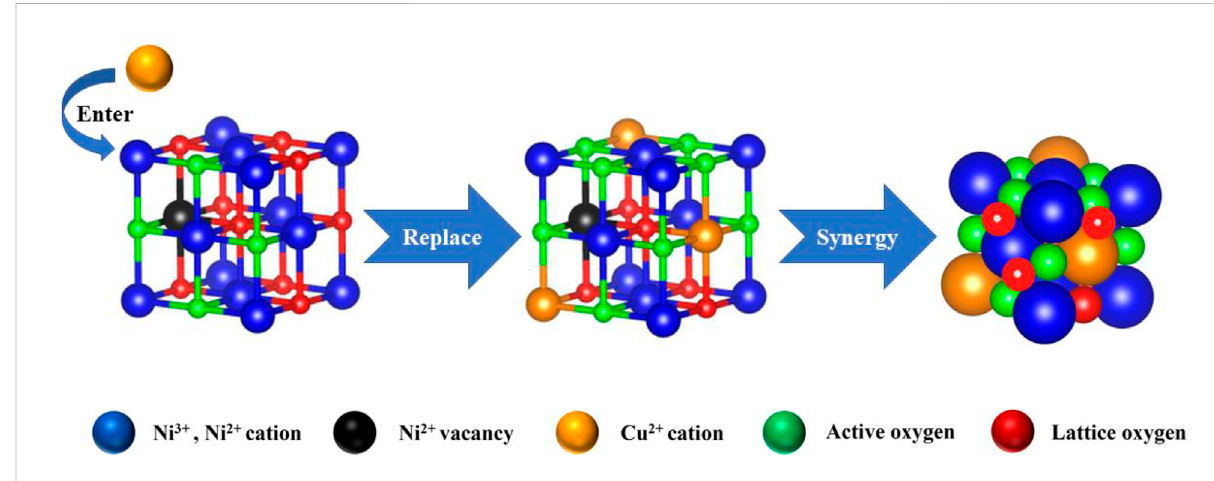
FIGURE 5 Reaction pathway of CMC over Cu – Ni oxide. Cited from Fan et al. (2022).